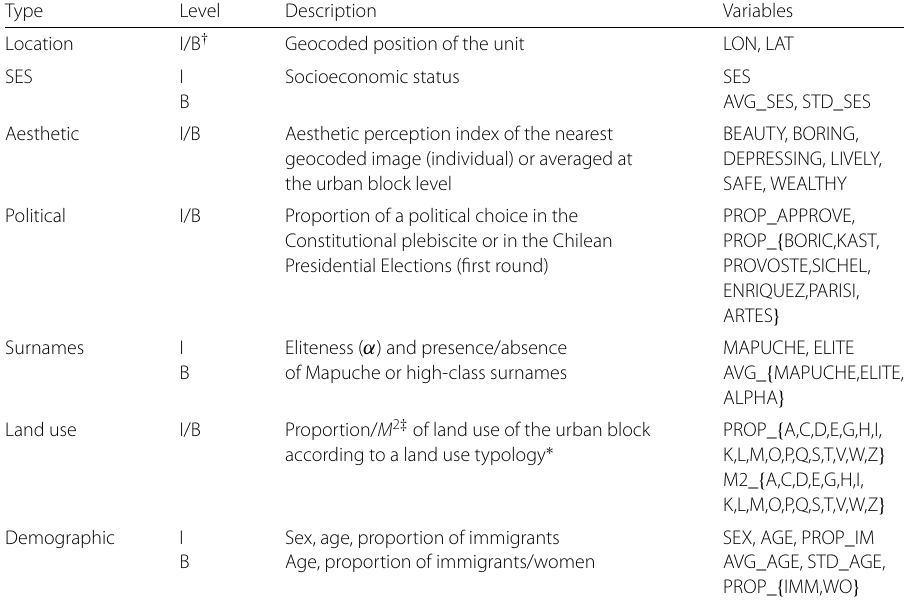
Table 1 Variables used in this study